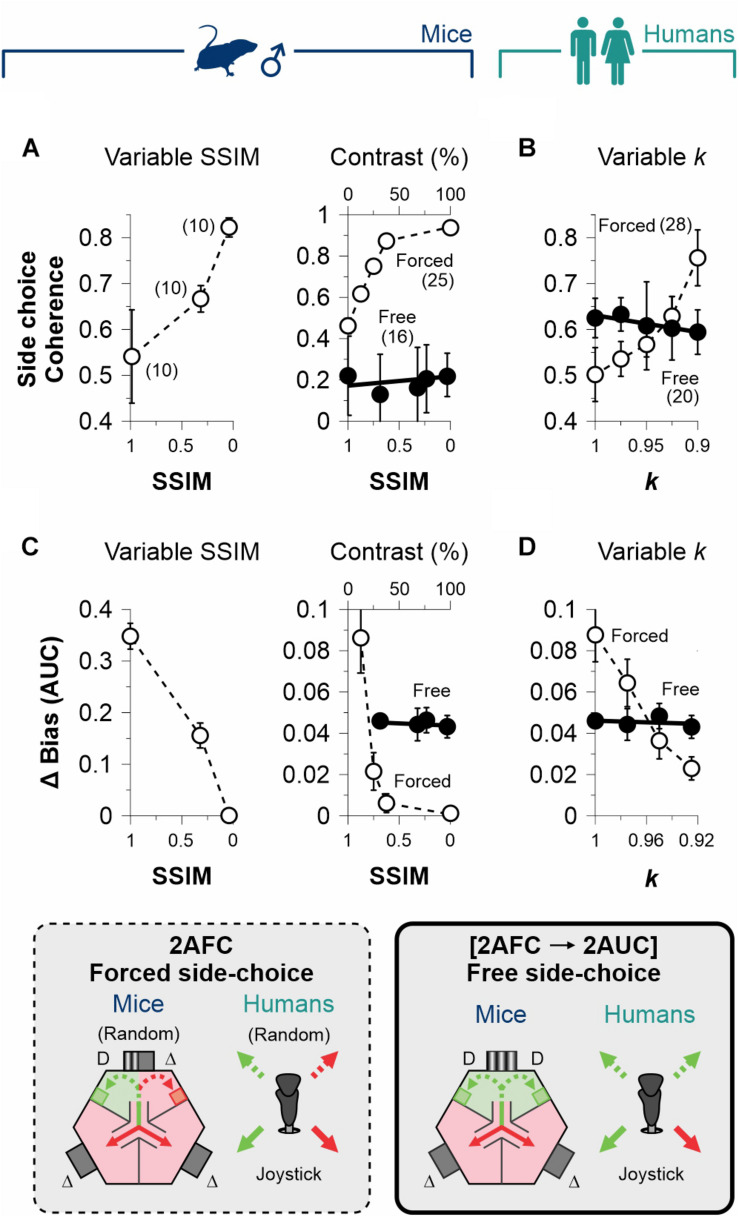
Dissociation of decisional biases from stimulus discriminability. (A) Group side-choice coherence as a function of stimulus discriminability in the 2AFC (empty circles) and 2AUC (filled circles) tasks for male mice (navy blue, A) and humans (dark cyan, B). Group coherence is sensitive to stimulus discriminability in the 2AFC tasks because subjects were tested with the same sequence of pseudo-randomized stimuli. Similarly, the difference in the area under the curve (AUC) of the bias probabilities reveals a dependency on discriminability for the 2AFC (empty circles) but not the 2AUC (filled circles) tasks for mice (C) and humans (D). Thus, decisional biases in the 2AUC tasks are independent of stimulus discriminability. Number of subjects in parentheses.